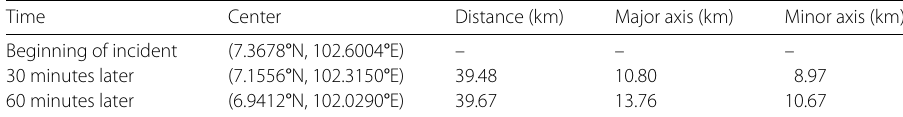
Table 1 The size in ellipse and position of oil slick starting at South Bongkot 5 oil drilling rig at different times.